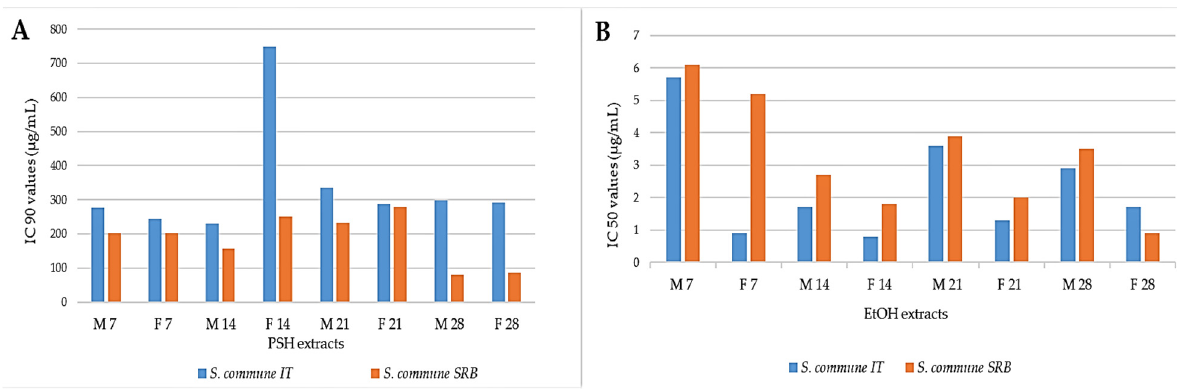
Figure 1. Comparative pre-presentation of acetylcholinesterase (AChE) inhibitory activity of two different isolates (Italy (IIT) and Serbia (SRB)) of S. commune :( A ) inhibitory activity of submerged polysaccharide (PSH) extracts presented as IC 90 values ( μ g/mL); ( B ) inhibitory activity of EtOH extracts presented as IC 50 values ( μ g/mL).